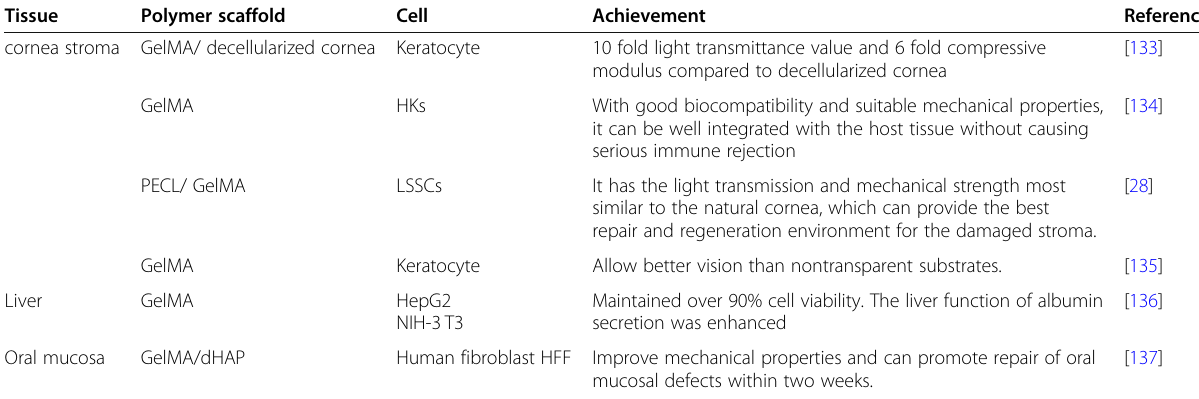
Table 8 The recent application of GelMA in cornea stroma and other tissue engineering Tissue Polymer scaffold